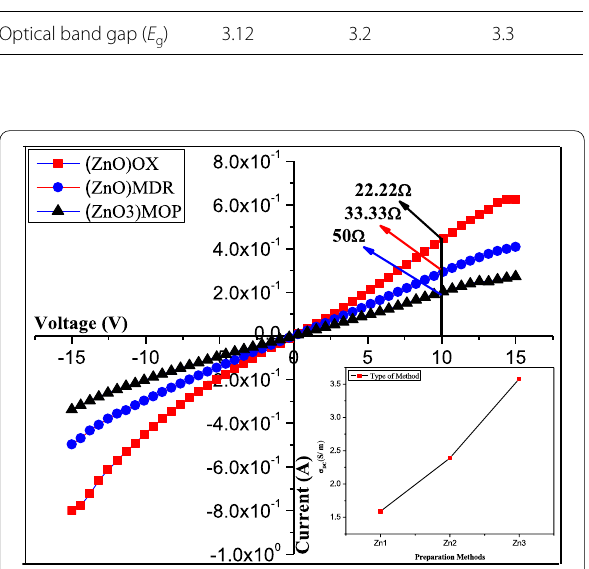
Fig. 3 I – V curve of (ZnONPS). The inner curve shows the electrical conductivity of ZnO NPs obtained using the three preparation